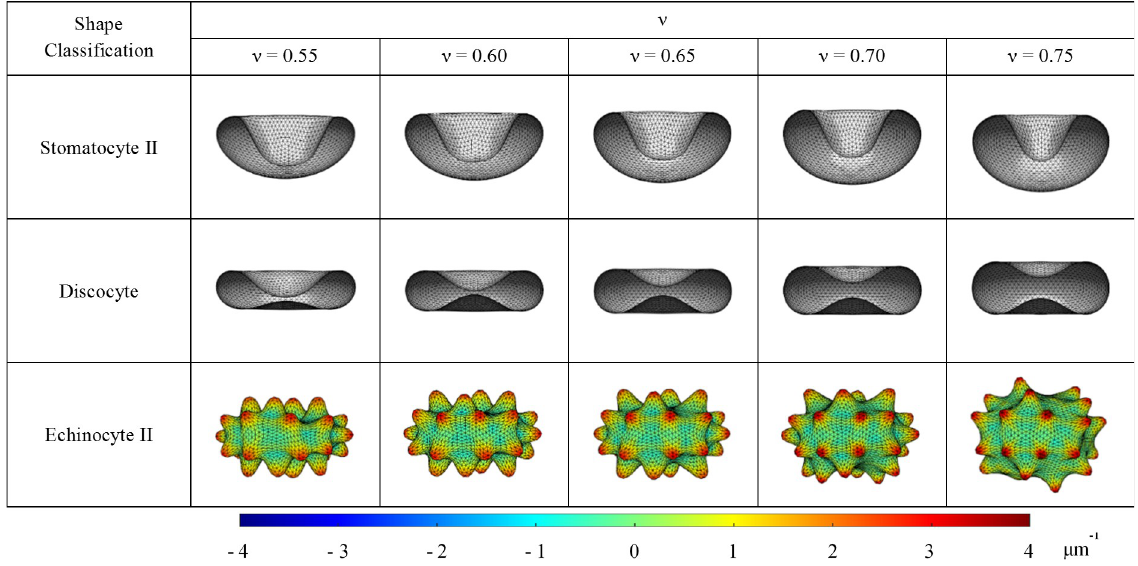
Fig 6. CG-RBC membrane model predicted stomatocyte II, discocyte and echinocyte II shapes at reduced cell volumes of ν = 0.55, 0.60, 0.65, 0.70 and 0.75. The coloured regions of the echinocyte II shape represent the membrane curvature on its’ vertex points ð C